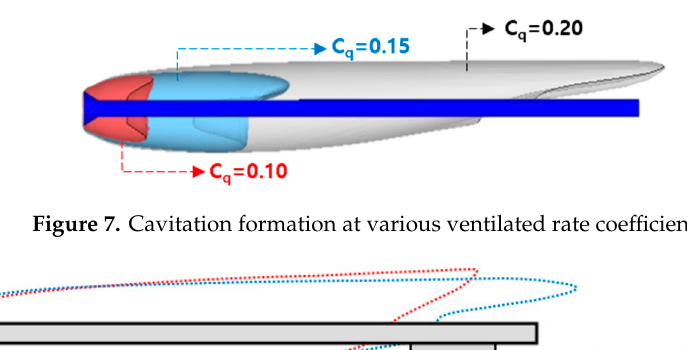
Figure 6. Cavitation formation at various ventilated rate coefficients: ( a ) Fn = 10.8, Cq = 0.10, ( b ) Fn = 10.8, Cq = 0.15, and ( c ) Fn = 10.8, Cq = 0.20. (Abbreviations: gas flux coefficient (Cq), flow field characteristic (Fn))